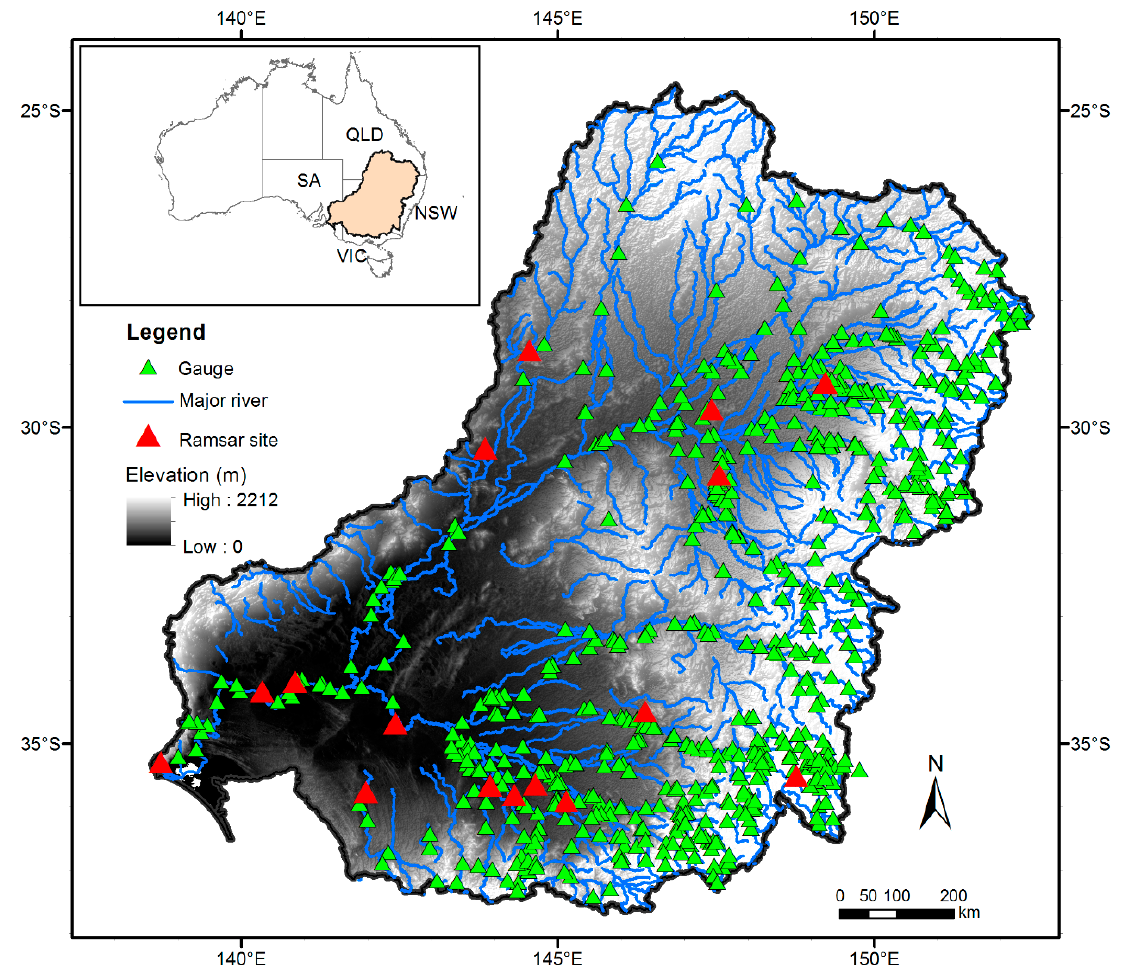
Figure 1. Study area: the Murray-Darling Basin (MBD).